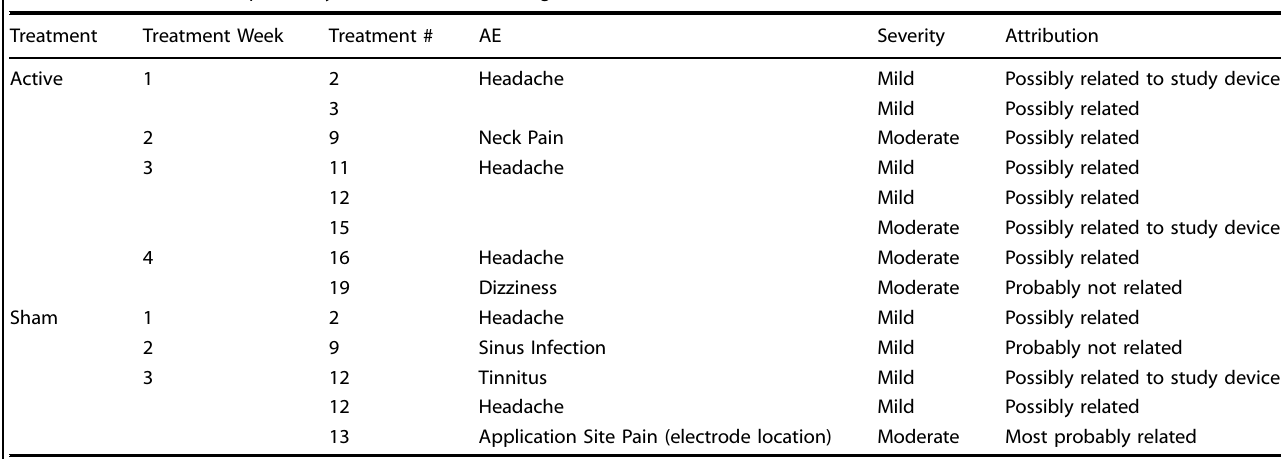
Table 6. Adverse events reported by rTMS technicians during treatment